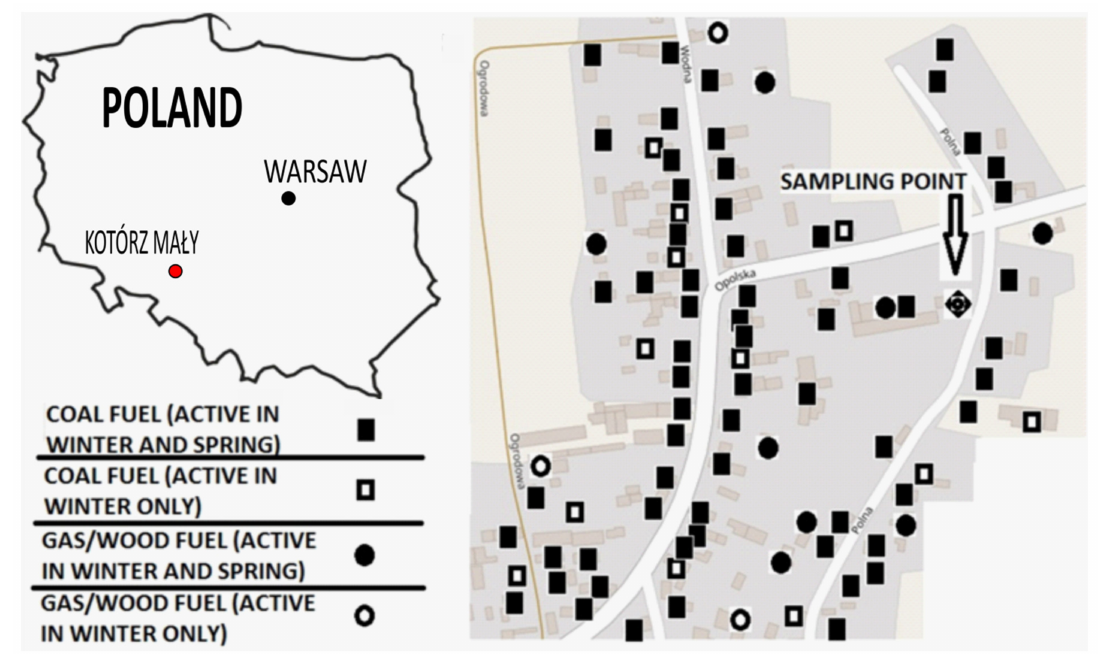
Figure 1. Location of sampling point with arrangement of point emission sources within a radius of 300 m from the sampling point (without a Renewable Energy Systems-RES; n = 11).